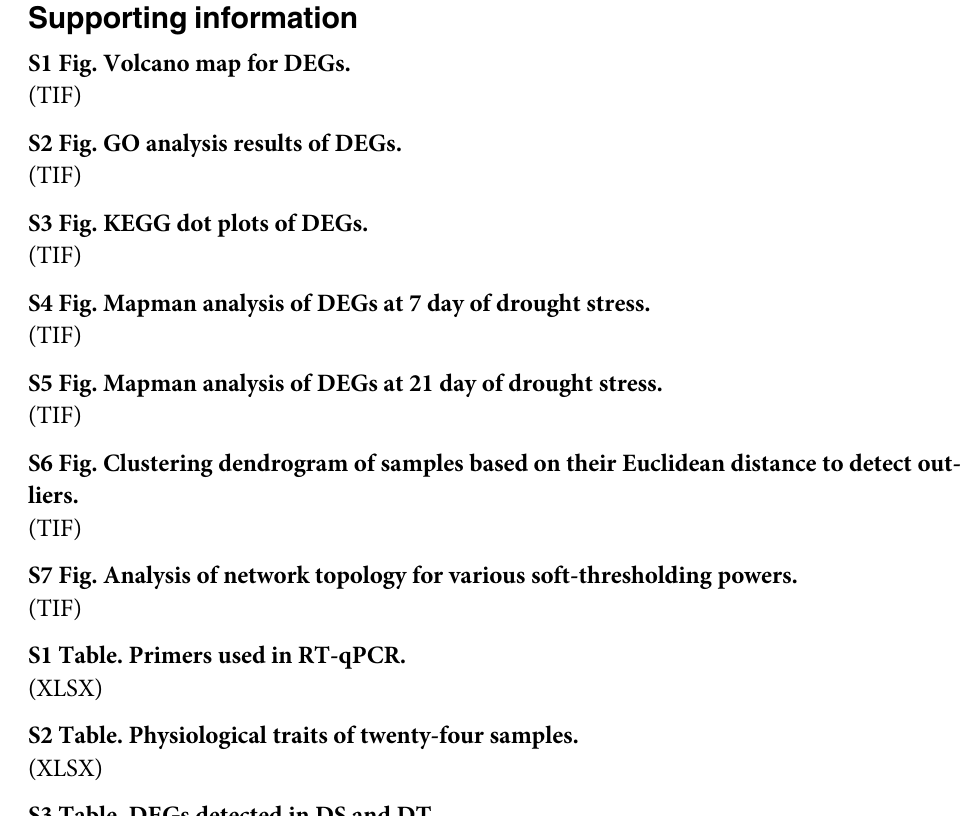
S3 Fig. KEGG dot plots of DEGs. S4 Fig. Mapman analysis of DEGs at 7 day of drought stress. S5 Fig. Mapman analysis of DEGs at 21 day of drought stress. S6 Fig. Clustering dendrogram of samples based on their Euclidean distance to detect out- liers. S7 Fig. Analysis of network topology for various soft-thresholding powers. S1 Table. Primers used in RT-qPCR. S2 Table. Physiological traits of twenty-four samples. S3 Table. DEGs detected in DS and DT. S4 Table. Results of Gene Ontology Analysis. S5 Table. Common GO-terms across DS and DT at same drought stress time points. (XLSX) S6 Table. Results of KEGG analysis. (XLSX) S7 Table. Common KEGG pathways across DS and DT at same drought stress time points. (XLSX) S8 Table. Transcription factors identified by iTAK. S9 Table. GO analysis of genes in two modules after redundancy by Revigo. S10 Table. KEGG analysis of genes in two